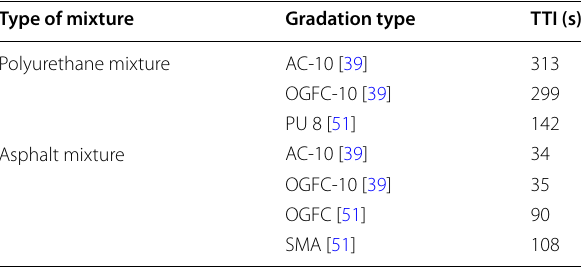
Table 5 The comparison of ignition time (TTI) between the polyurethane mixture and asphalt mixture